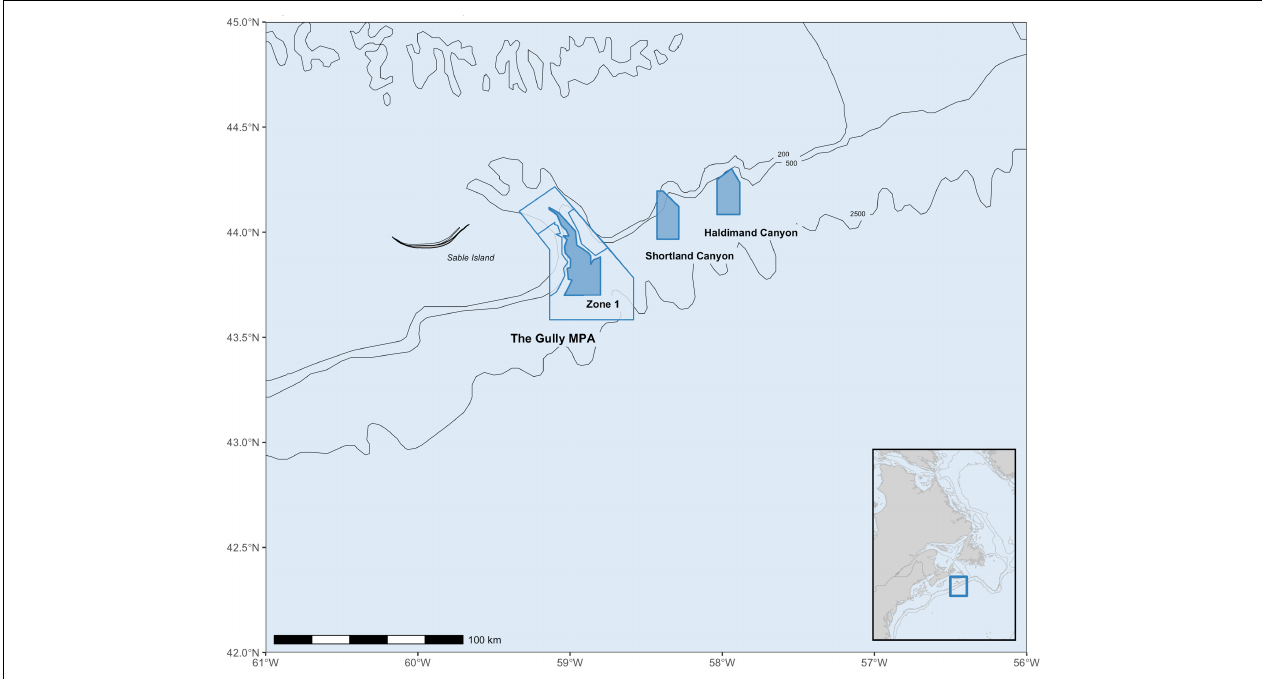
FIGURE 1 | Study area extent on the Scotian Shelf. Research over the period 1988–2019 was focused in the Gully MPA (outlined in blue), particularly the deep waters of Zone 1 (shaded blue polygon). After 2001 research expanded to include Shortland and Haldimand canyons (shaded blue polygons). These shaded blue areas are also currently designated as critical habitat for northern bottlenose